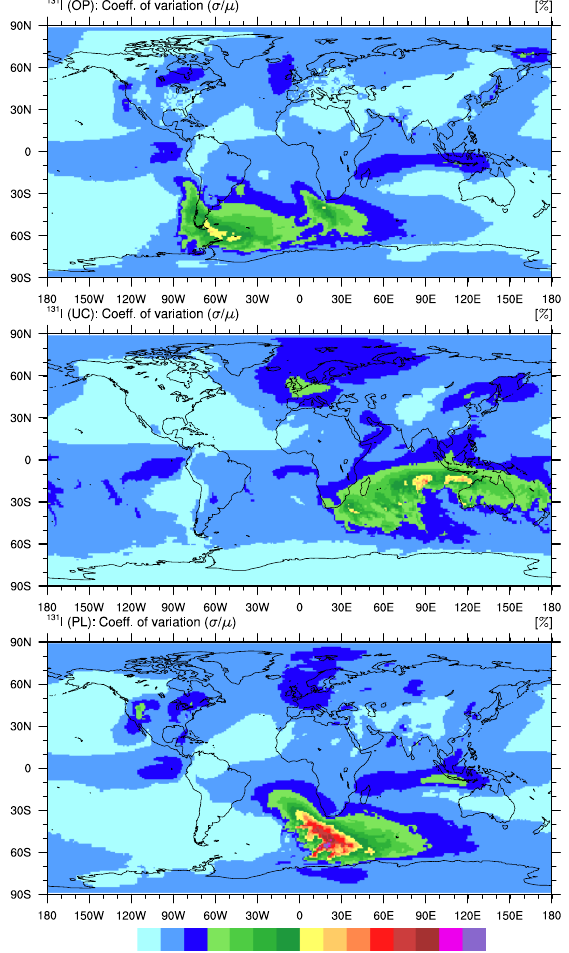
Fig. 4. Top to bottom: Operating, under construction, and planned or proposed nuclear power plant relative risk coefficient of variation ( σ/µ ), over the period 2010–2030.